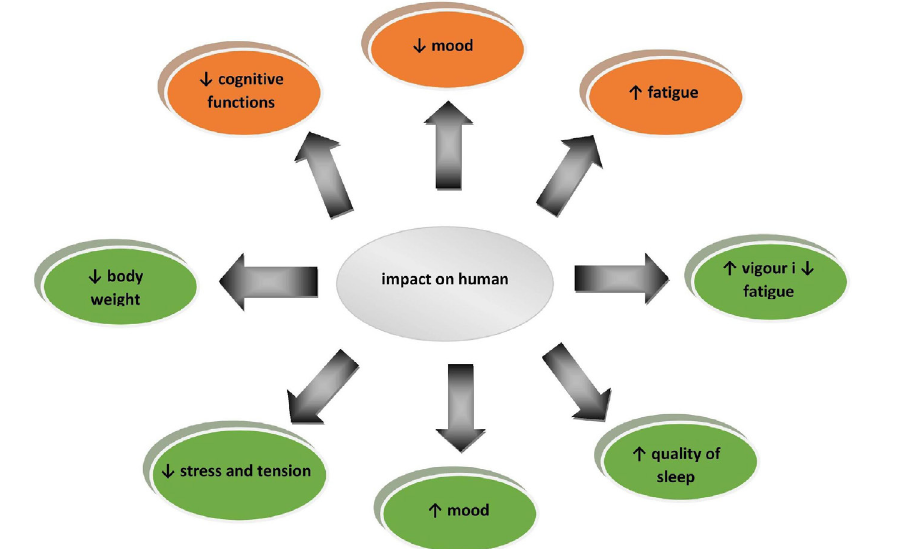
Fig. 1. The impact of DR and IF on mental health and well-being based on the results of clinical